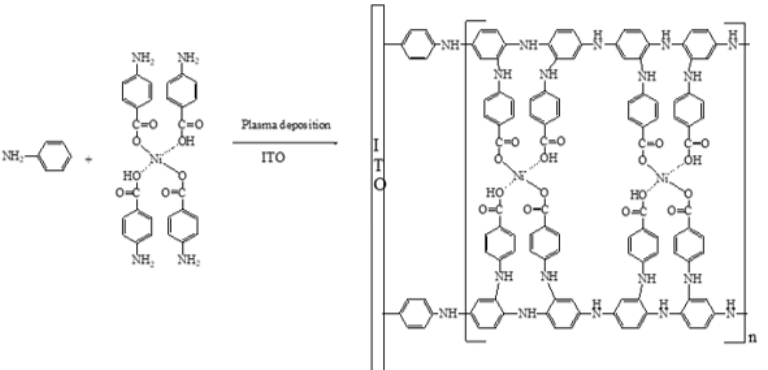
Figure 8. Schematic preparation of polyaniline Ni-complex catalytic electrode by plasma process for detection of phosphate.